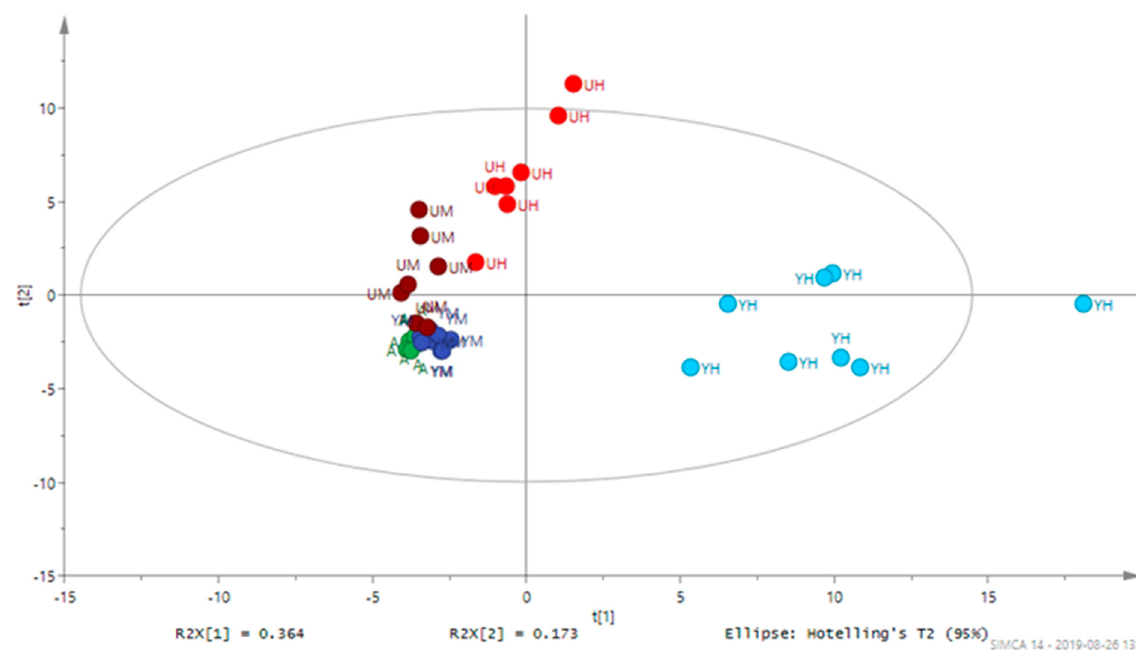
Figure 1. PCA score plot showing metabolomic separation of sets of eight replicates of Chlorella cultures after 8 days of cultivation in the following growth conditions: autotrophic ( A ), mixotrophic with glycerol ( YM ), heterotrophic with glycerol ( YH ), mixotrophic with glucose ( UM ), heterotrophic with glucose ( UH ). Eight replicates for each growth condition are shown.